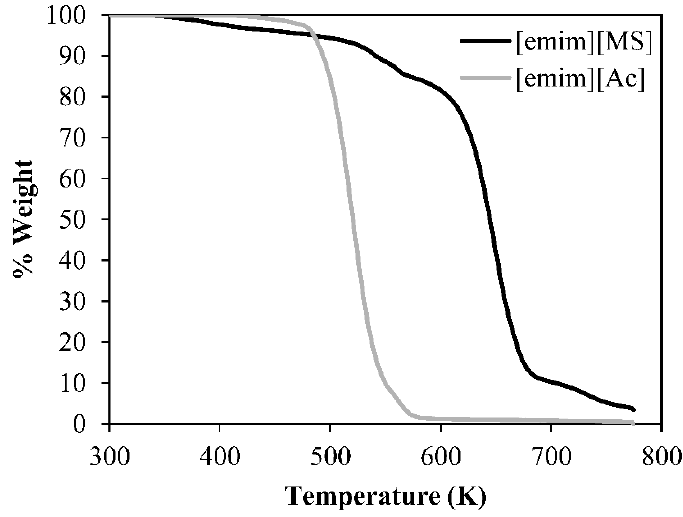
Figure 5. TGA analysis for the [emim][MS] and [emim][Ac] ionic liquids. Table 4. Viscosity of [emim][Ac] and [emim][MS] and contact angle measured between the membrane and the